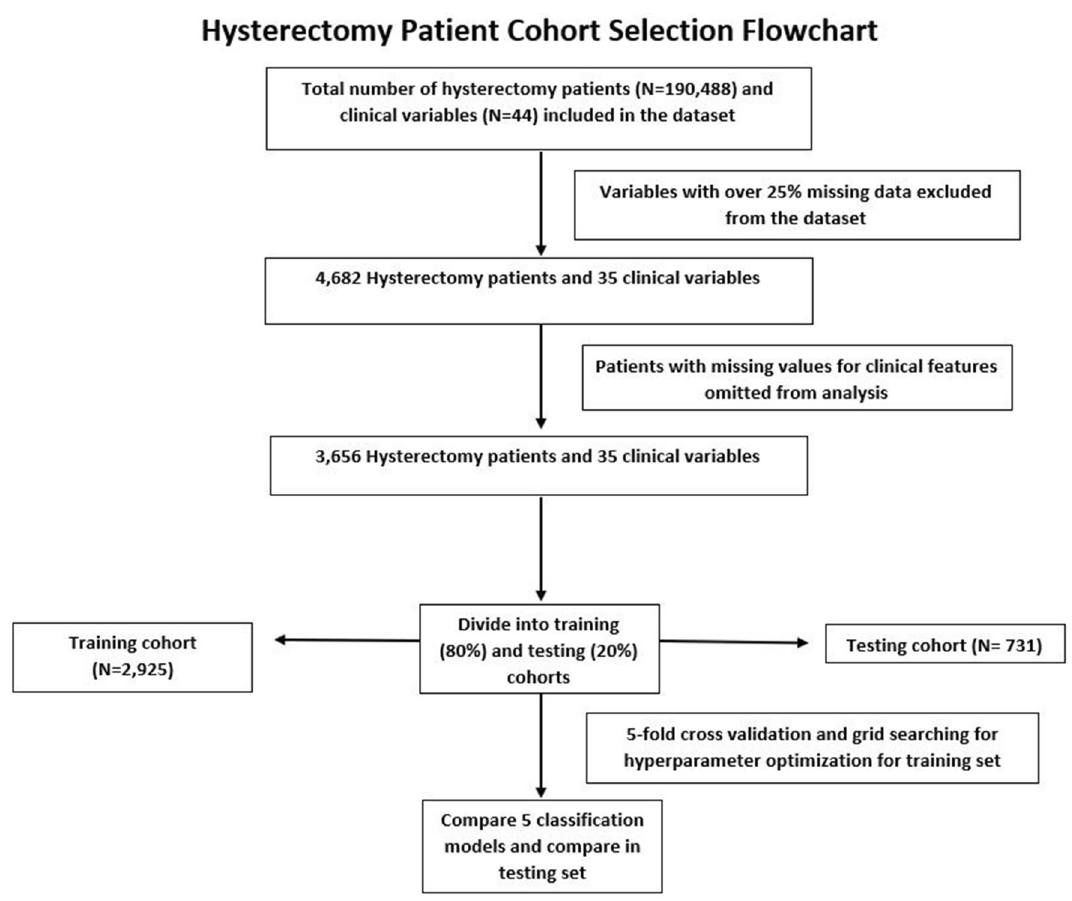
Figure 1. Flow chart showing the hysterectomy patient cohort selection, model training, and performance evaluation processes. A total of 3656 patients were used for model development and were randomly divided into an 80% training set (2925 patients) and a 20% testing set (731 patients). k-fold cross-validation and grid searching for hyperparameters was conducted in the training set, and model performance was evaluated based on area under receiver operating characteristic curves and accuracy